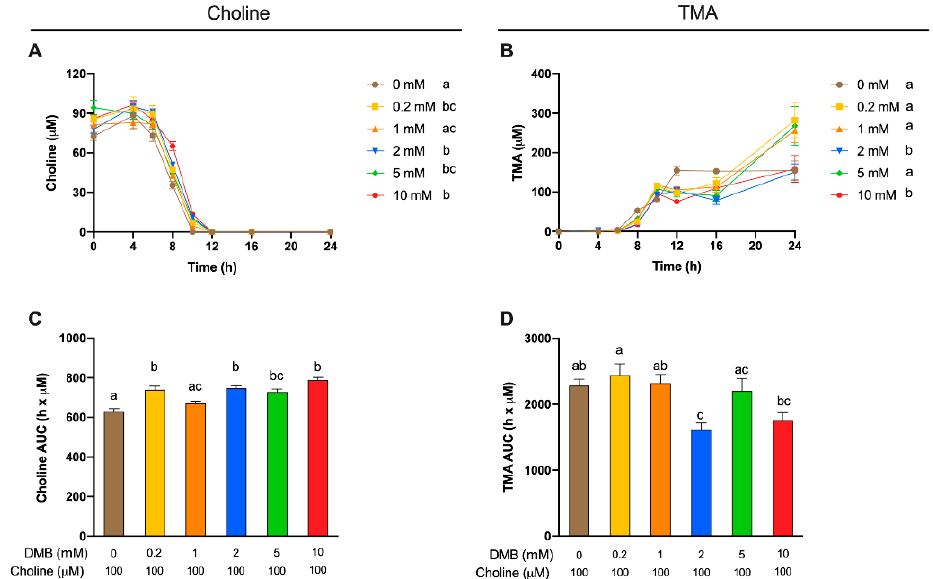
Figure 4. Choline ( A ) and TMA ( B ) kinetic curves obtained from fermentations with fecal slurry 20%, choline 100 µ M and DMB concentrations of 0–10 mM. Results are expressed as mean ( µ M choline or TMA) ± SEM ( n = 6), and for choline, time-matched choline concentrations in the background (0 µ M choline) are subtracted from choline-supplemented conditions. Areas under the curve (AUCs) from choline ( C ) and TMA ( D ) fermentations. Results are expressed as mean (h × µ M of choline or TMA) ± SEM ( n = 6), and for choline, time-matched choline concentrations in the background (0 µ M choline) are subtracted from choline-supplemented conditions. Different letters indicate statistical differences ( p < 0.05) by two-way (( A , B ) main effect of DMB concentration) or one-way ( C , D ) ANOVA (Tukey’s post hoc test). Factors for two-way ANOVA were DMB concentration and time. Apparent choline concentrations at initial conditions (0 h) were different between DMB-free and DMB 5 mM (Figure 5A). Choline concentrations for all timepoints